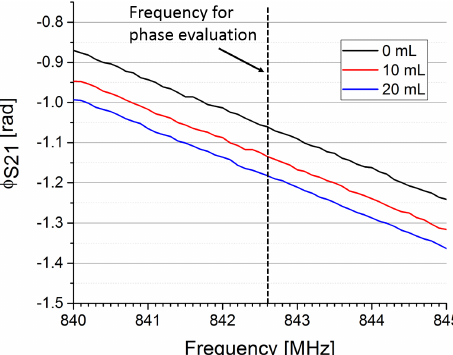
Figure 5. Phase response of the S 21 parameter for three different water volumes pushed in the upper compartment. The increase in permittivity by pushing water in the upper compartment signifi- cantly decreases the overall phase in the observed frequency range. The phase was evaluated at a fixed frequency (dotted